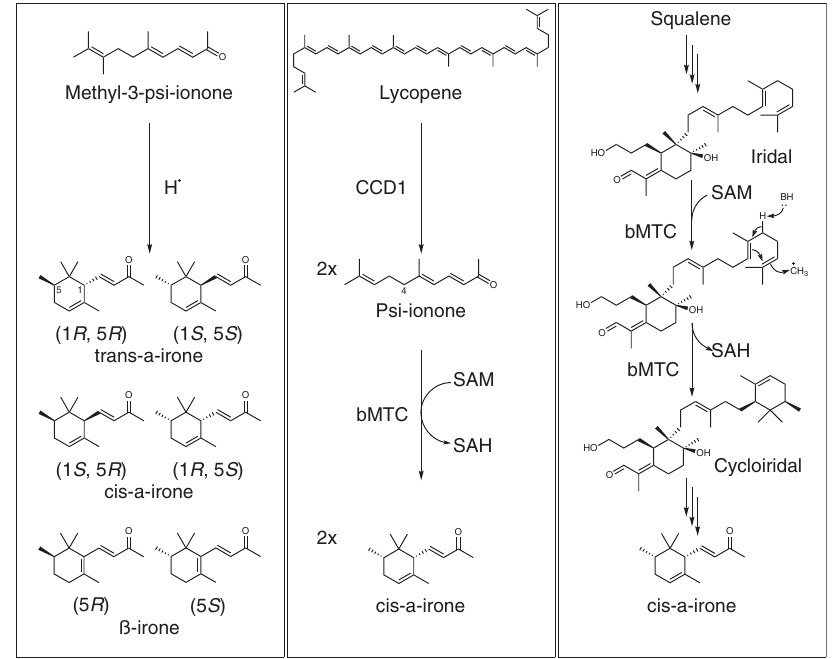
Fig. 1 | Schematic representations of the different pathways to produce irone. The chemical route uses acid to catalyse cyclization of methyl-3-psi-ionone, which is not a known natural product. Chemical synthesis produces a racemic mixture containing (1 R , 5 R )-trans- α -irone (1R5R),(1 S , 5 S )-trans- α -irone (1S5S), (1 S , 5 R )-cis- α -irone(1S5R),(1 R ,5 S )-cis- α -irone(1R5S),(5 R )- β -ironeand(5 S )- β -irone.Thenative biosynthesis route was proposed based on a radiolabelling study 9 , and a bifunc- tional methyltransferase and cyclase (bMTC) was hypothesized to convert iridal directlyto cycloiridal. Cycloiridalisasymmetric,so onlyone moleculeof α -irone is producedfromtheC30precursor.Theresultingcarbonyieldis46.7%.Thearti fi